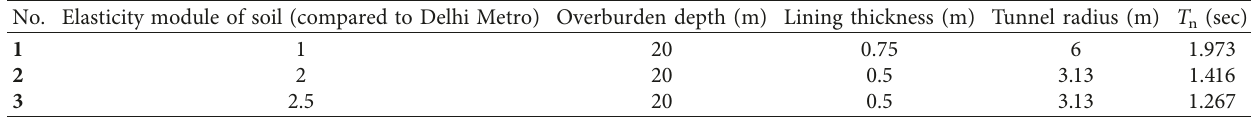
Table 7: Properties of models that presence of the tunnel amplifies the acceleration spectrum at a distance of 5.83 m from the center of the tunnel projection onto the ground surface.